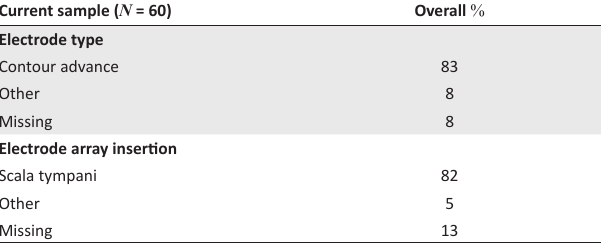
TABLE 3: Electrode array type and insertion in the current sample ( N =